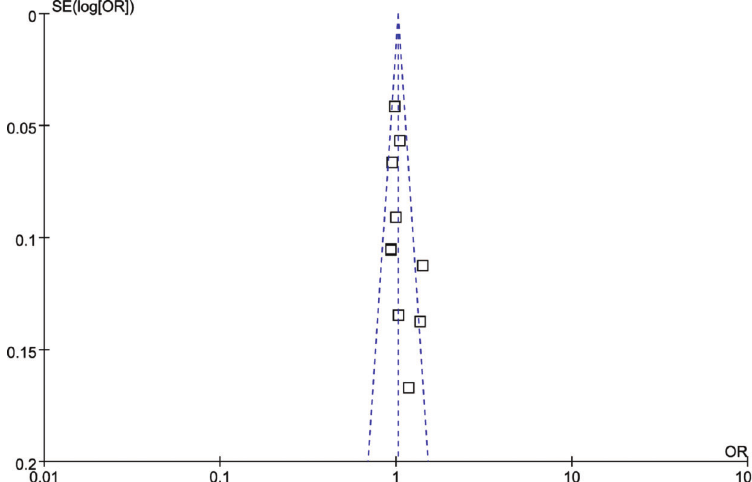
Figure 4 - Funnel plot analysis to detect publication bias (G vs. A of the rs11196218A/G polymorphism). Each point represents an independent study on the indicated association. The dark point represents two overlapping